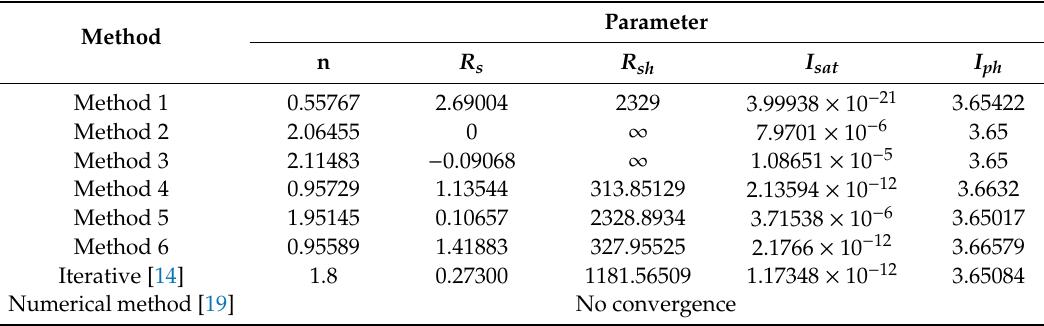
Table 4. Parameters for the Thin film (Sanyo 180BA19).